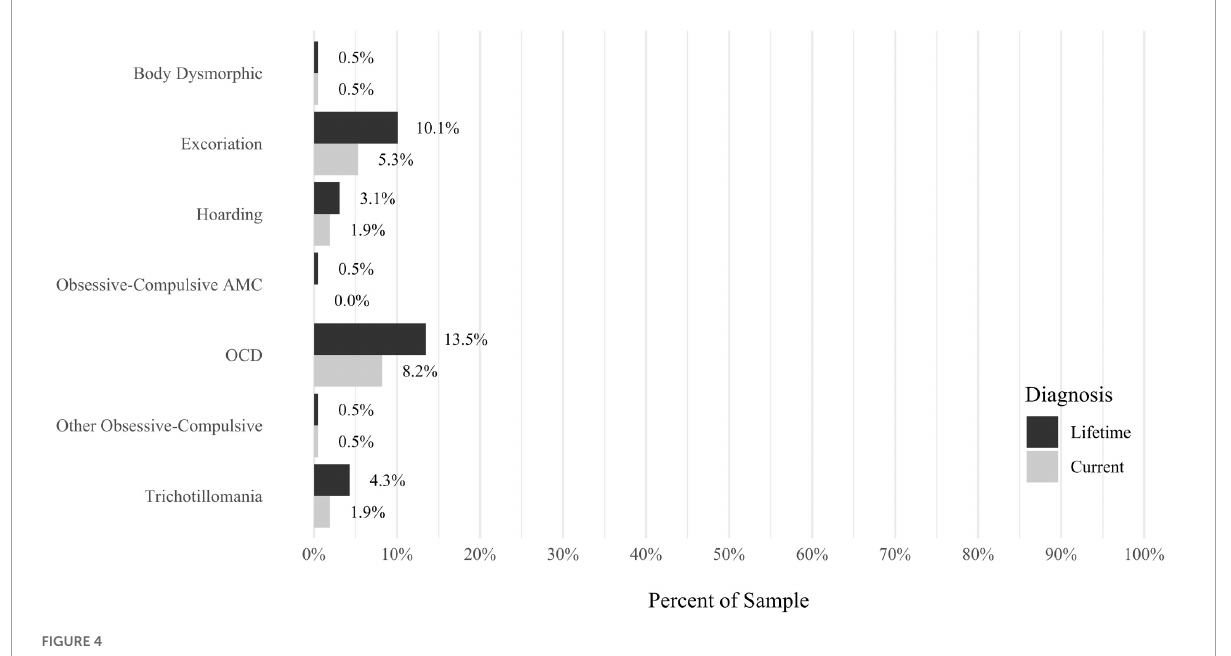
FIGURE4 Rates of psychiatric disorders: obsessive compulsive disorders.